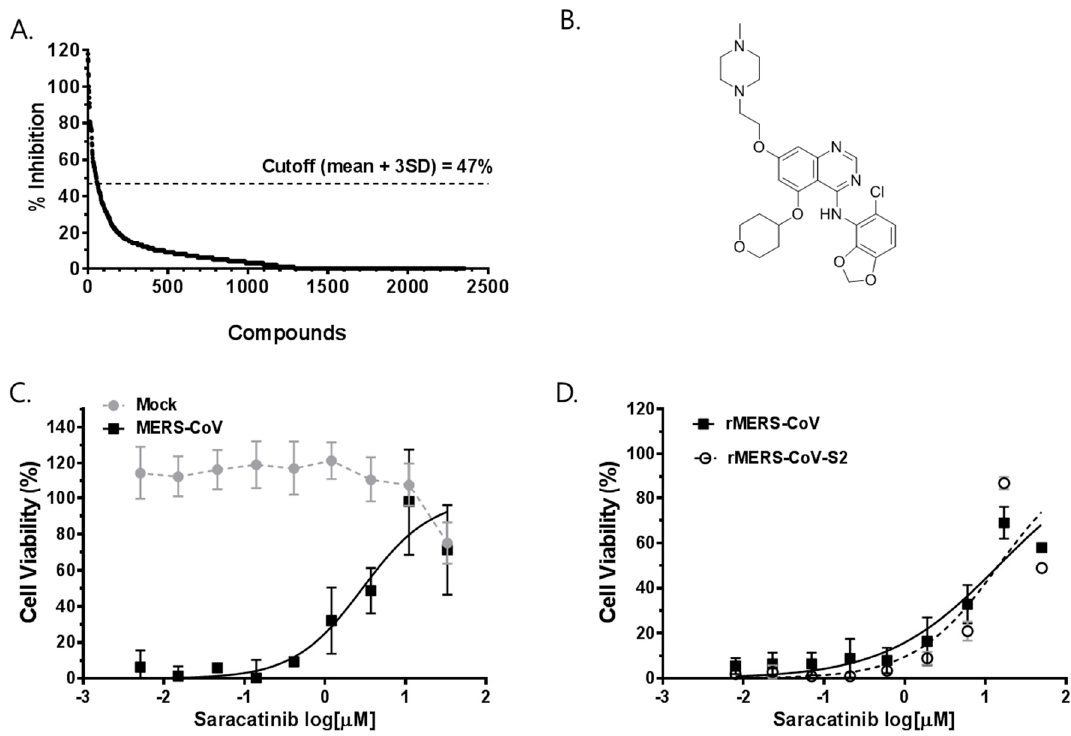
Figure 1. Identification of saracatinib as an anti-MERS-CoV inhibitor from screening of bioactive compound libraries. ( A ) The percentage inhibition of MERS-CoV induced-CPE from each compound in the primary screening. Each dot represents the individual compound tested. The hit identification was based on the calculation of average % inhibition ± 3 standard deviation (mean ± 3SD) cut-off, which in this study was 47% inhibition of the virus induced-CPE. ( B ) The structure of saracatinib. ( C , D ) Dose-response curve (DRC) analyses of the inhibition of MERS-CoV by saracatinib. Huh-7 cells were ( C ) mock-infected (grey circle) or infected with MERS-CoV (black square); ( D ) rMERS-CoV (black square) and rMERS-CoV-S2 (open circle) in the presence of various concentrations of saracatinib. At 72 h p.i., cell viability was measured using MTS-based CellTiter 96 ® AQ ueous One Solution Cell Proliferation Assay. The data represent means ( ± SD) of at least two independent experiments performed in duplicate.